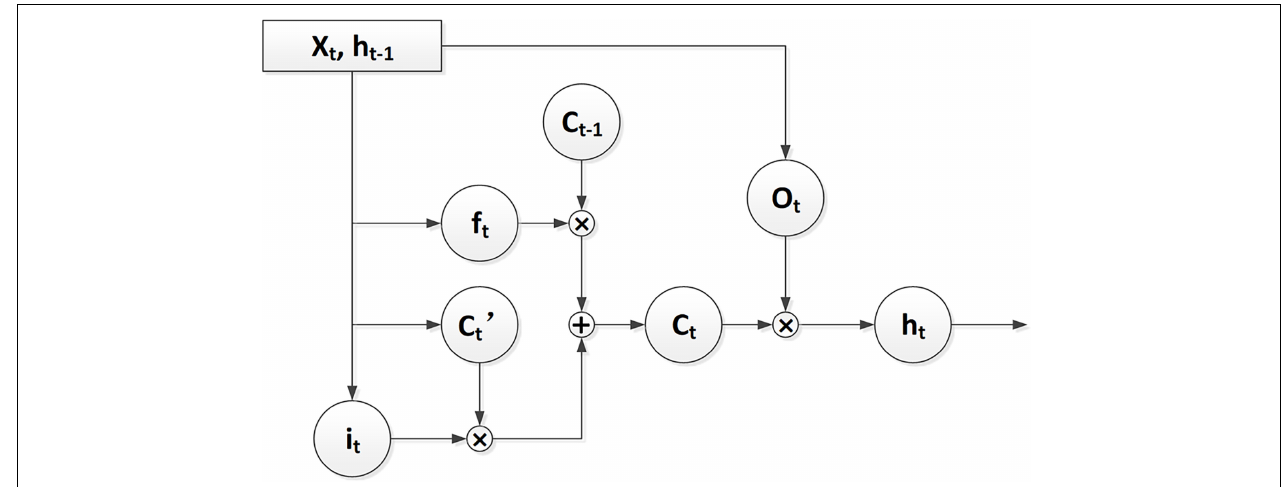
FIGURE 1 | The flow chart of LSTM